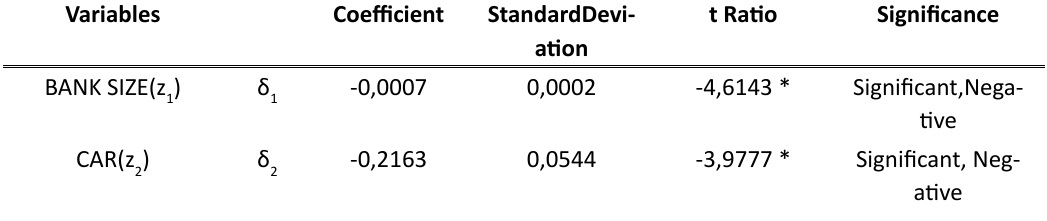
Table 2: Results of Factors Affecting Profit